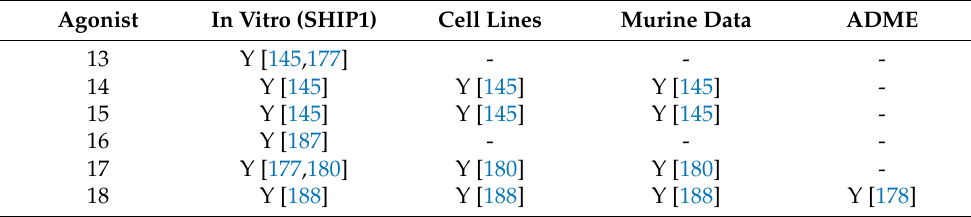
Table 2. Summary of SHIP1